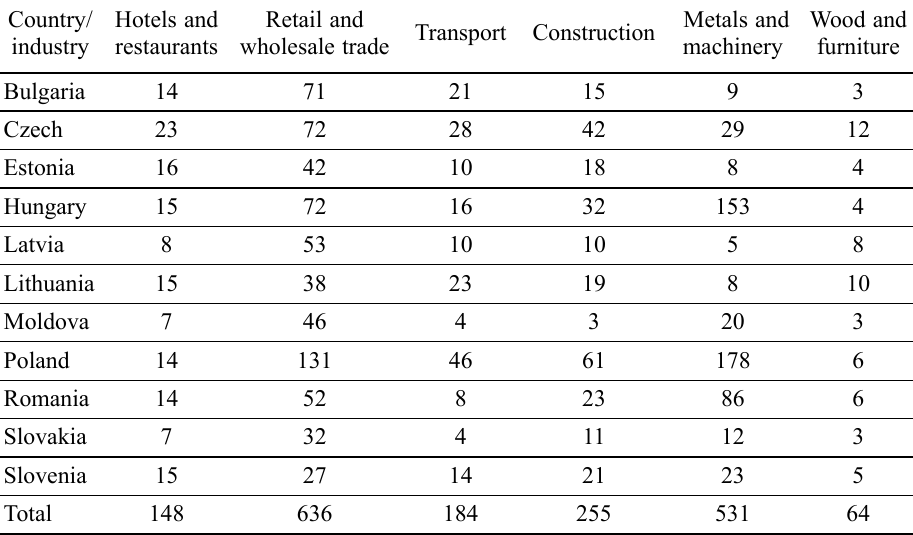
Table 2. Number of firms analyzed by both industry and country (year 2005) Country/